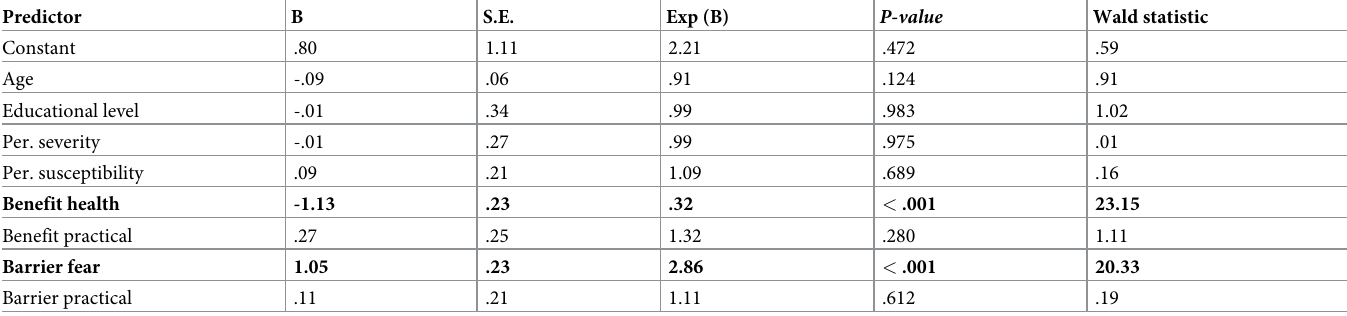
Table 4. Results of logistic regression with age, educational level and predictors as defined in the health belief model predicting hesitancy about vaccination in young adults.